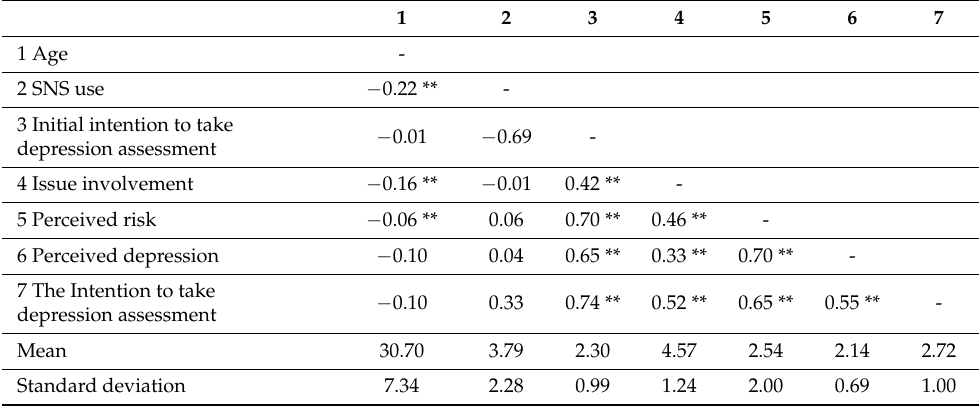
Table 4. Descriptive analysis and correlations between control and dependent